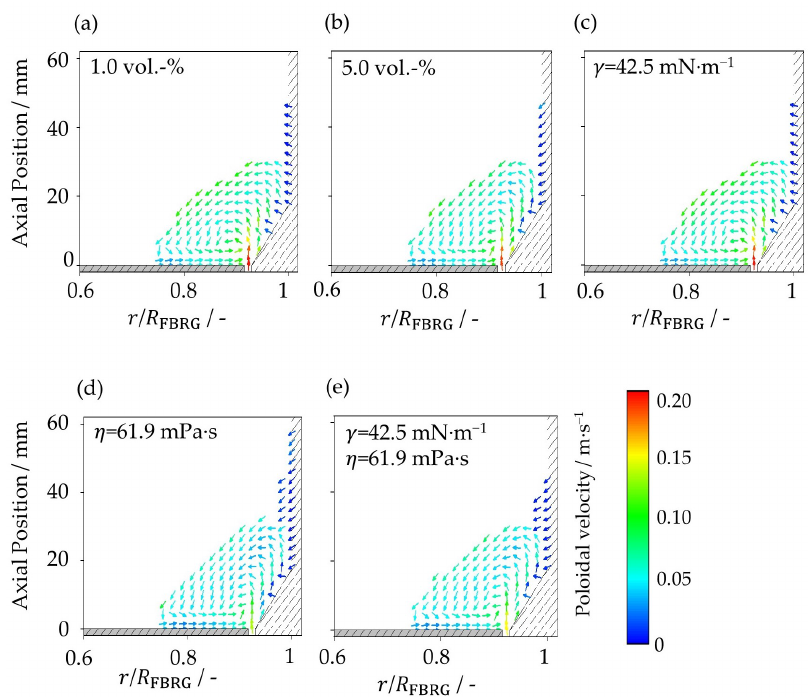
Figure 6. Poloidal distribution of poloidal particle velocity at ( a ) liquid loading of 1 vol.-%, ( b ) liq- uid loading of 5 vol.-%, ( c ) surface tension of 42.5 mN∙m −1 , ( d ) viscosity of 61.9 mPa∙s, and ( e ) sur- · m − 1 , ( d ) viscosity of 61.9 mPa · s, and ( e ) surface face tension of 42.5 mN∙m −1 and viscosity of 61.9 mPa∙s. loading of 5 vol.-%, ( c ) surface tension of 42.5 mN tension of 42.5 mN · m − 1 and viscosity of 61.9 mPa ·